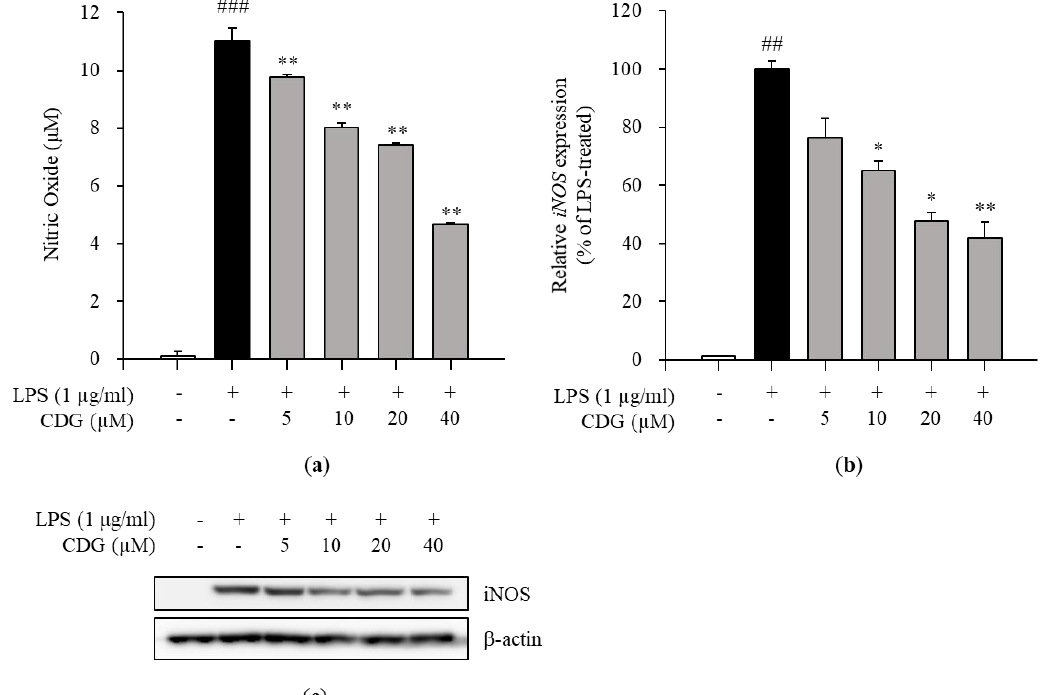
Figure 2. Effect of CDG on NO production and iNOS expression. The ImKC cells were treated with CDG (5, 10, 20, and 40 µ M) for 2 h and stimulated by LPS (1 µ g/mL) for the experiment. ( a ) After LPS treatment for 24 h, the NO production was measured and quantified using a standard curve for nitrite solution. The NO production level is shown via a bar graph. Data are represented as the mean ± standard deviation. ( b ) After LPS treatment for 3 h, the mRNA expression of iNOS was measured and compared with LPS-treated control group set at 100%. iNOS mRNA expression levels are shown with a bar graph. Data are represented as the mean ± standard deviation. ( c ) After LPS treatment for 24 h, the protein expression levels of iNOS were measured and compared with those in the LPS-treated control group. ## p < 0.01 and ### p < 0.001 relative to the untreated control group. * p < 0.05 and ** p < 0.01 relative to the LPS-treated and CDG-untreated group. CDG, cate-